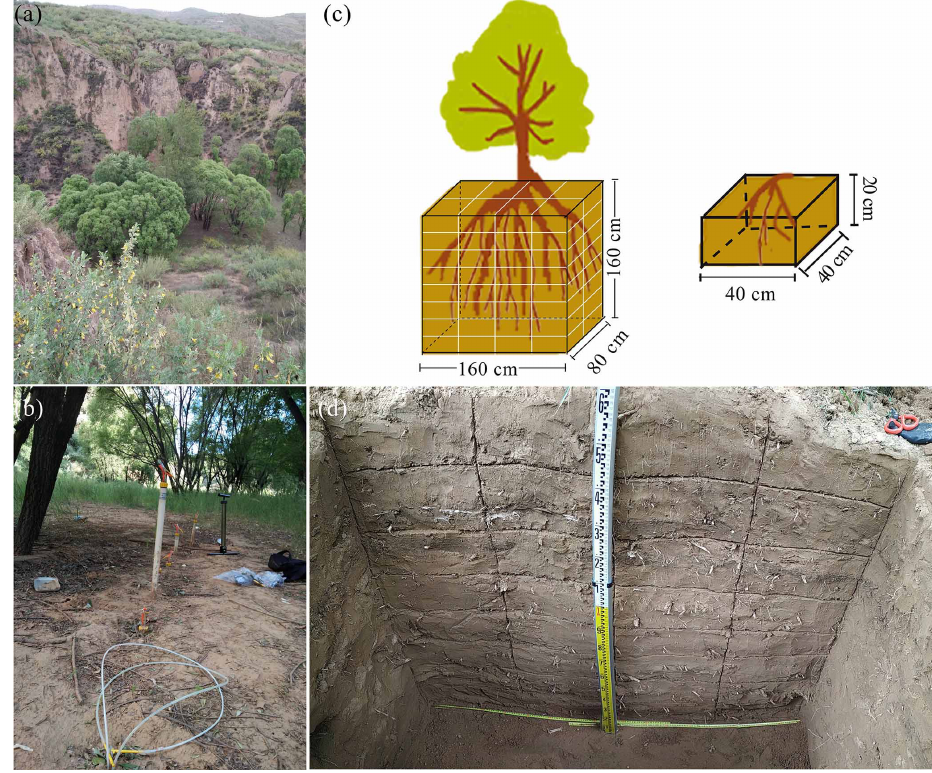
Figure 1. (a) Photograph of Salix matsudana Koidz, our sampling tree. (b) Mobile water collection using suction lysimeters (white plastic tubes) (with the application of 60kPa of tension). (c) Schematic diagram of the root excavations and measurements as described in Sect. 2.2. (d) Profile of the soil cuboid (length, width and depth: 160, 80 and 160cm, respectively) that was dug to obtain root isotopic data. The soil cuboid was divided into 64 subcuboids, and the root isotopes in each subcuboid (length, 40cm; width, 40cm; height, 20cm) were collected separately.